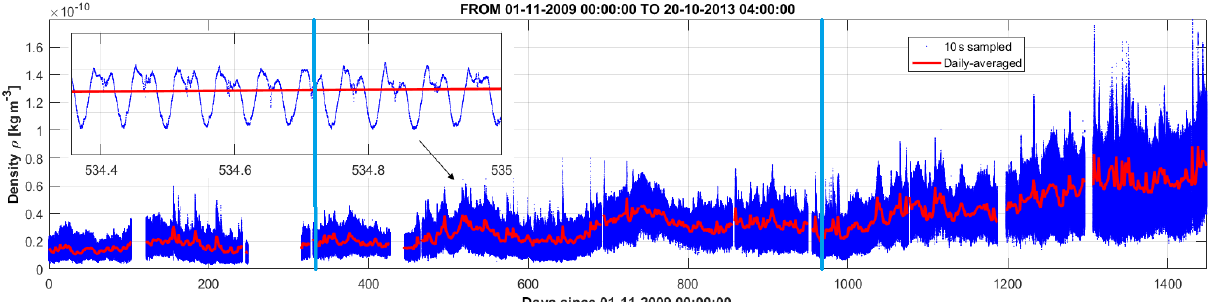
Figure 3. Thermospheric density from GOCE data. Density profile, provided at a 10s sampling rate (blue line), is averaged over 1d (red line). In the inset sub-plot, a time span of only 10 orbits is plotted. The periodic, high-frequency fluctuations of density are due to satellite orbit, lasting around 90min. In the main plot, day 0 is the start of operations (1 November 2009). Blue vertical lines at day 327 (24 September 2010) and 976 (4 July 2012) indicate the limits of the three sub-datasets of low, rising and high solar activity (see also Fig. 2). Low-orbit campaign starts on day 1004 (1 August 2012), almost completely overlapping with the low-orbit campaign. The RSS (root sum of squares) error in density (not shown) is also provided in the dataset, setting a level 2 orders of magnitudes lower than the average density.